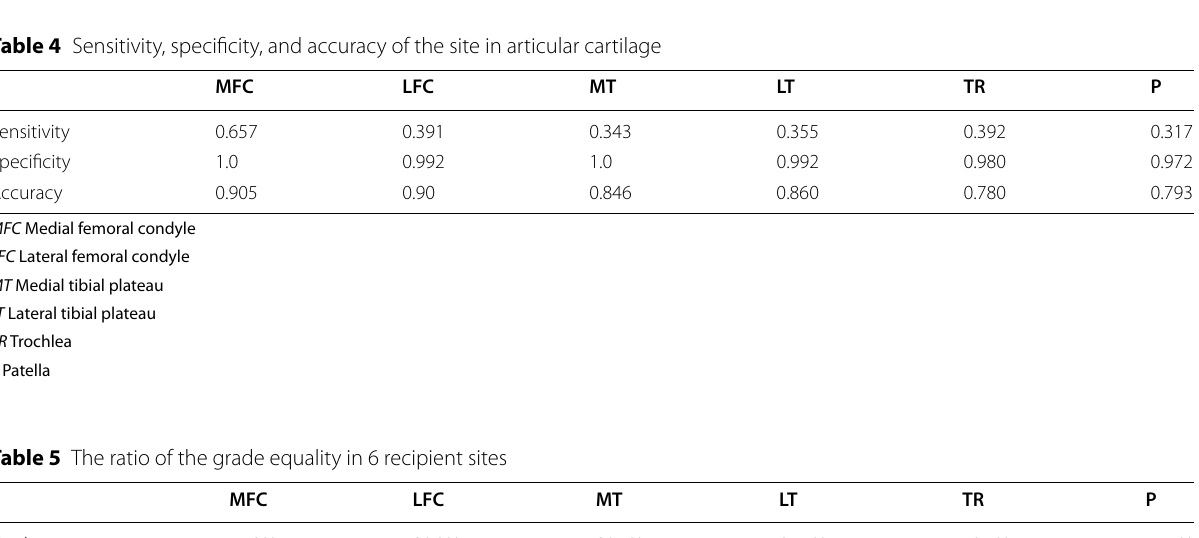
Table 4 Sensitivity, specificity, and accuracy of the site in articular cartilage